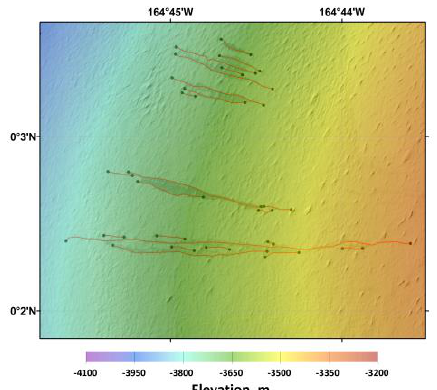
Figure 10. Portion of HiRiSE DEM generated from stereo pair (PSP_009371_1800, PSP_009516_1800) with automated correlation method implemented in PHOTOMOD to measure slope streaks (red lines) in crater Nicholson on Mars.